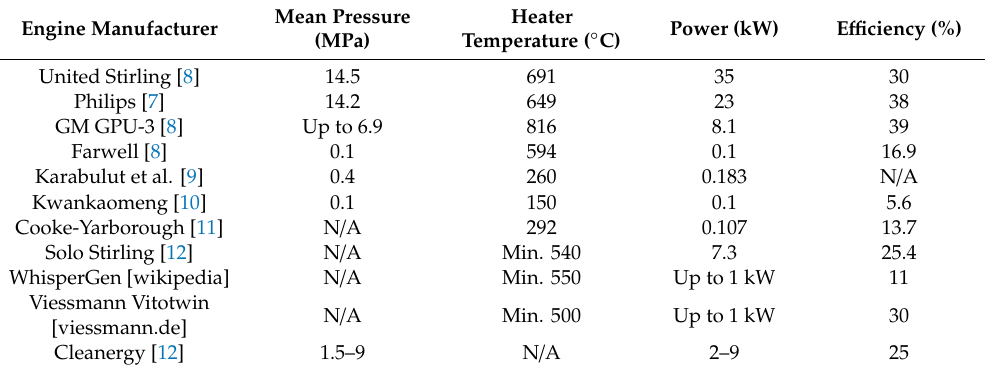
Table 1. List of Stirling engines.